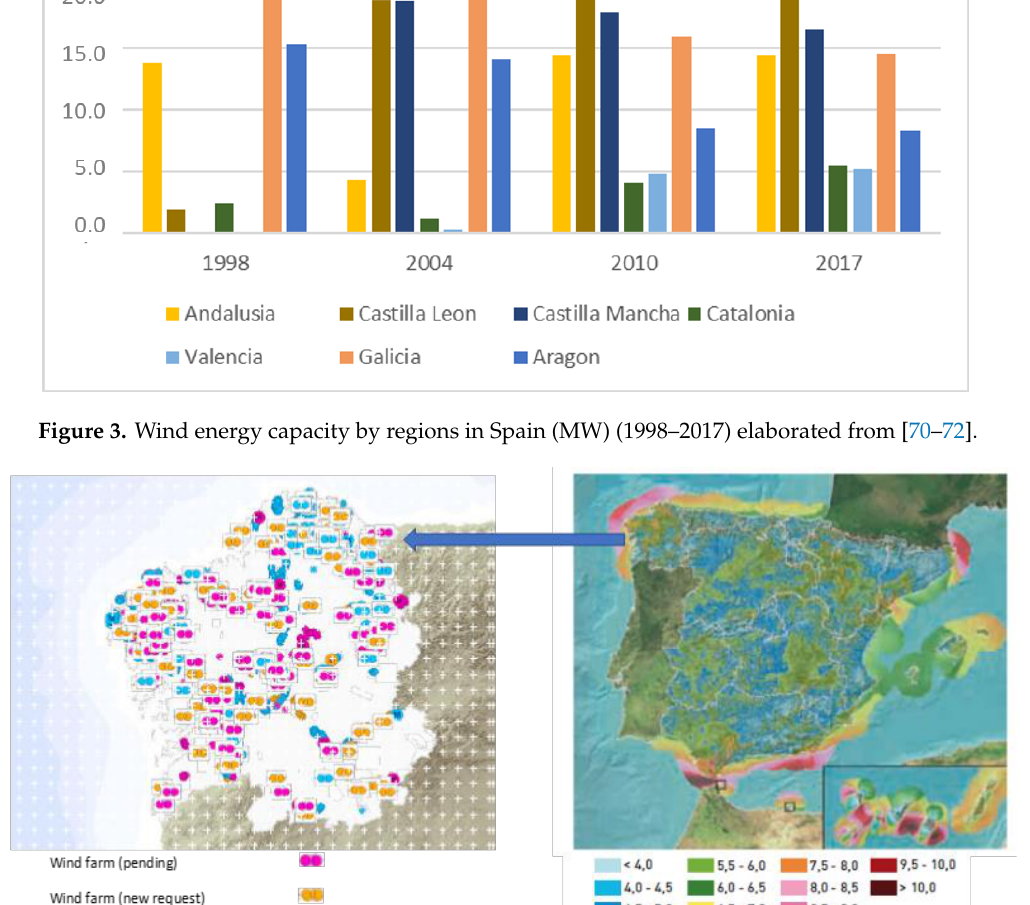
Figure 4. Map of the Wind Registry of Galicia ( left ) and Wind Atlas of Spain at a wind speed of 60 (60, 80 and 100 m, are considered a range of representative hub heights of medium and heavy-duty commercial wind turbines existing on the market) meters/second ( right ) elaborated from [70,73] p. 21.